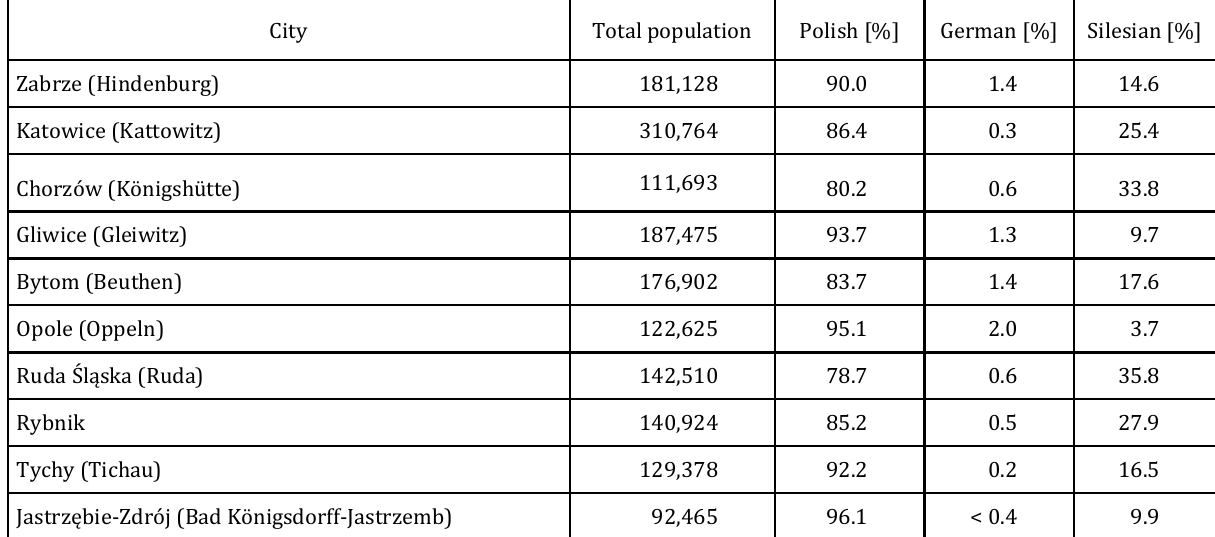
Table 2. Ethnic composition of the largest cities in Upper Silesia 2011 (own computation based on 2011 Polish census results) City Total population Polish [%] German [%] Silesian [%] Zabrze (Hindenburg) 181,128 Katowice